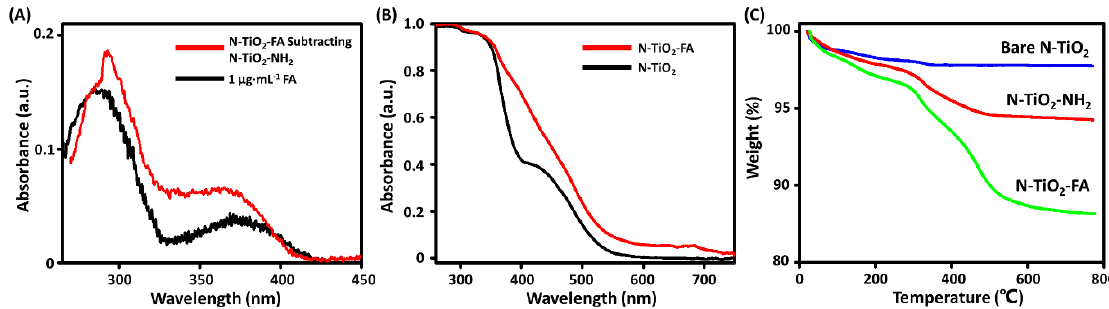
Figure 2. ( A ) Comparison of the absorption spectrum of 1 μ g·mL − 1 folic acid (FA) solution and the subtraction spectrum of N-TiO 2 -FA subtracting N-TiO 2 -NH 2 ; ( B ) Absorption spectra of N-TiO 2 and N-TiO 2 -FA NPs; ( C ) Thermogravimetric analysis of the air-dried N-TiO 2 , N-TiO 2 -NH 2 and N-TiO 2 -FA